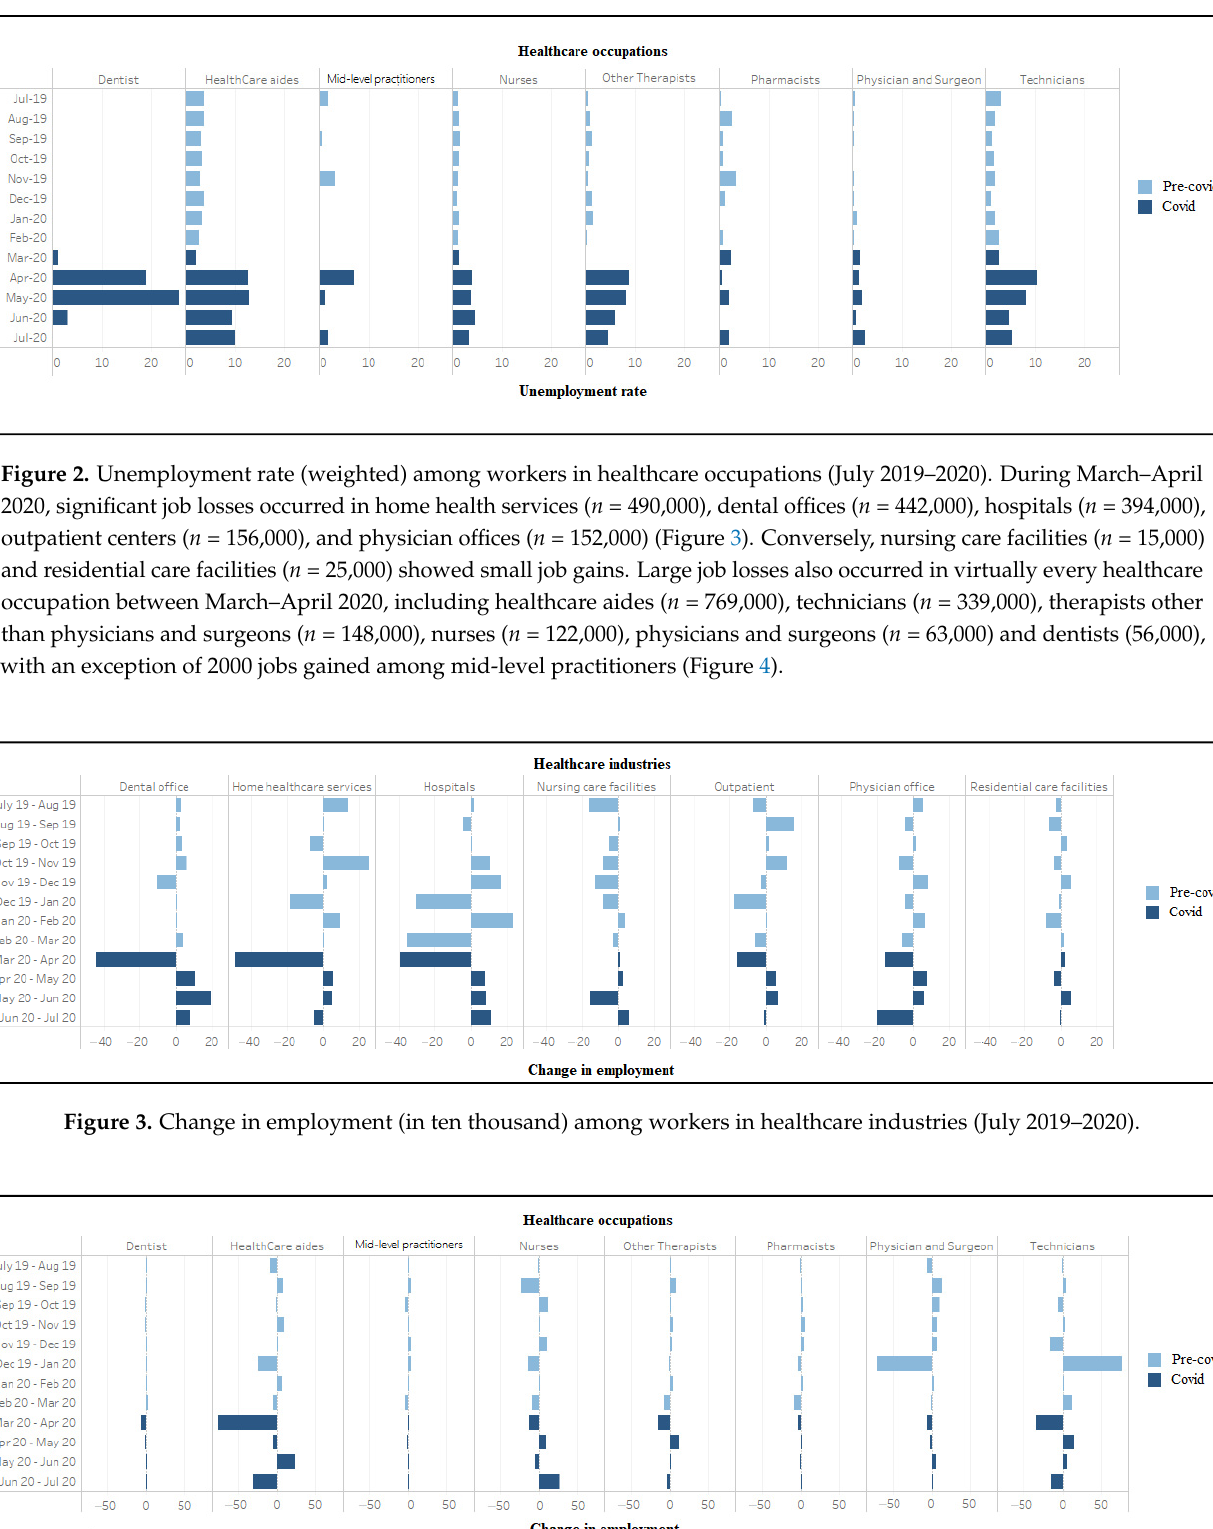
Figure 2. Unemployment rate (weighted) among workers in healthcare occupations (July 2019–2020). During March–April